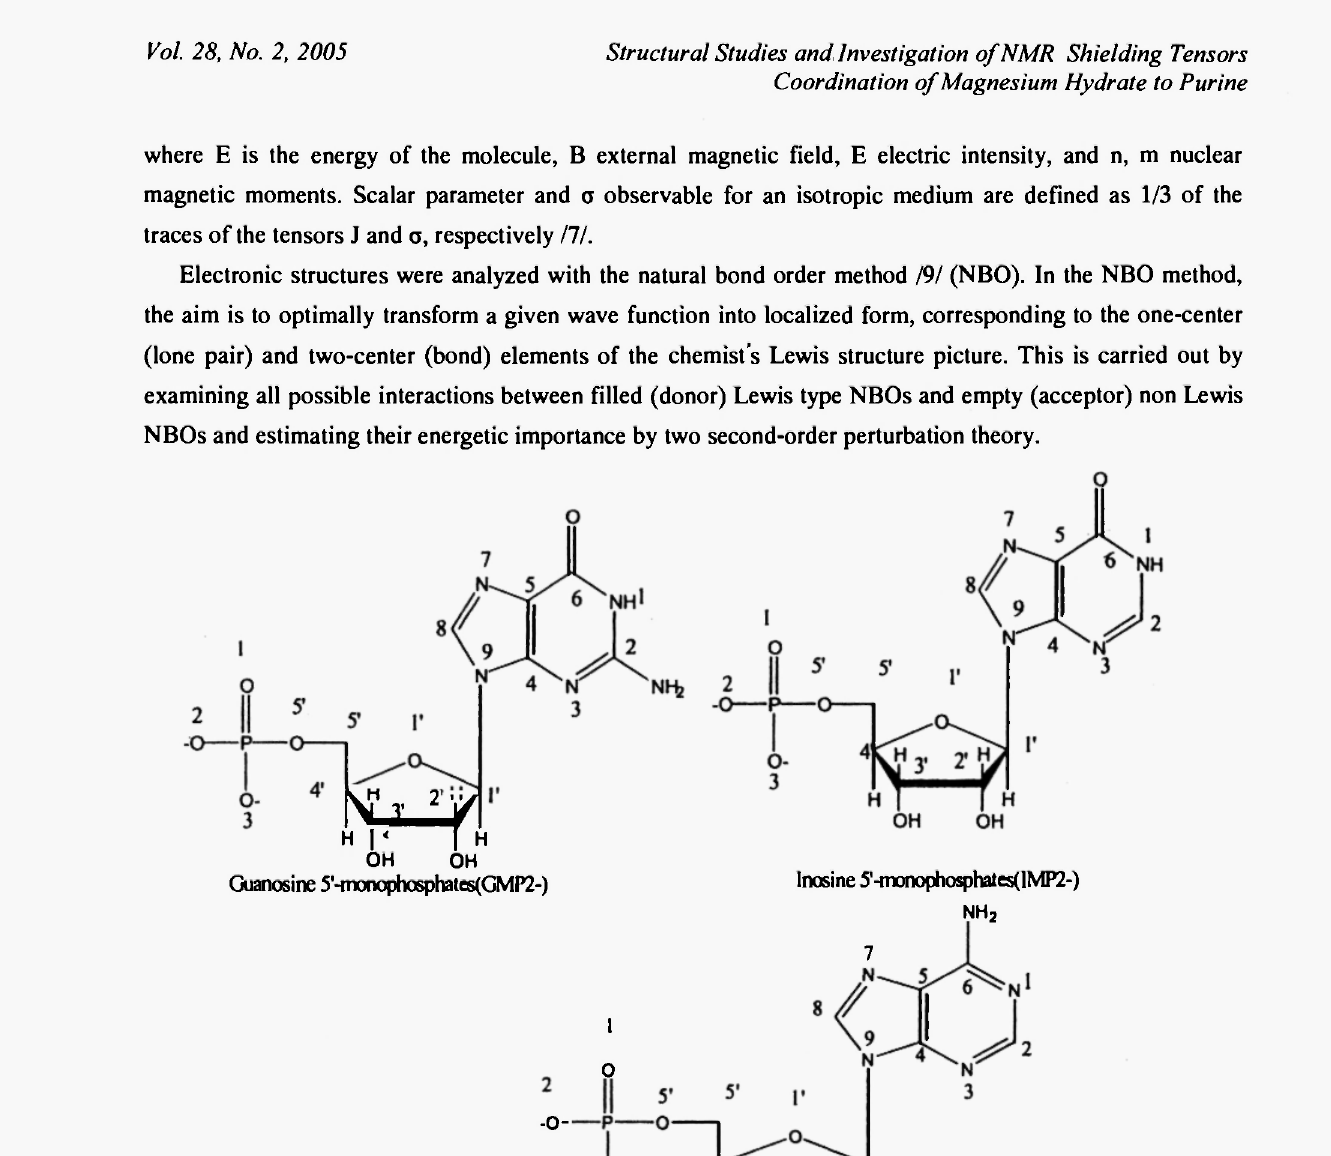
Fig. 1: Chemical structures of the purine-nucleoside 5'-monophosphates (AMP, GMP, IMP).